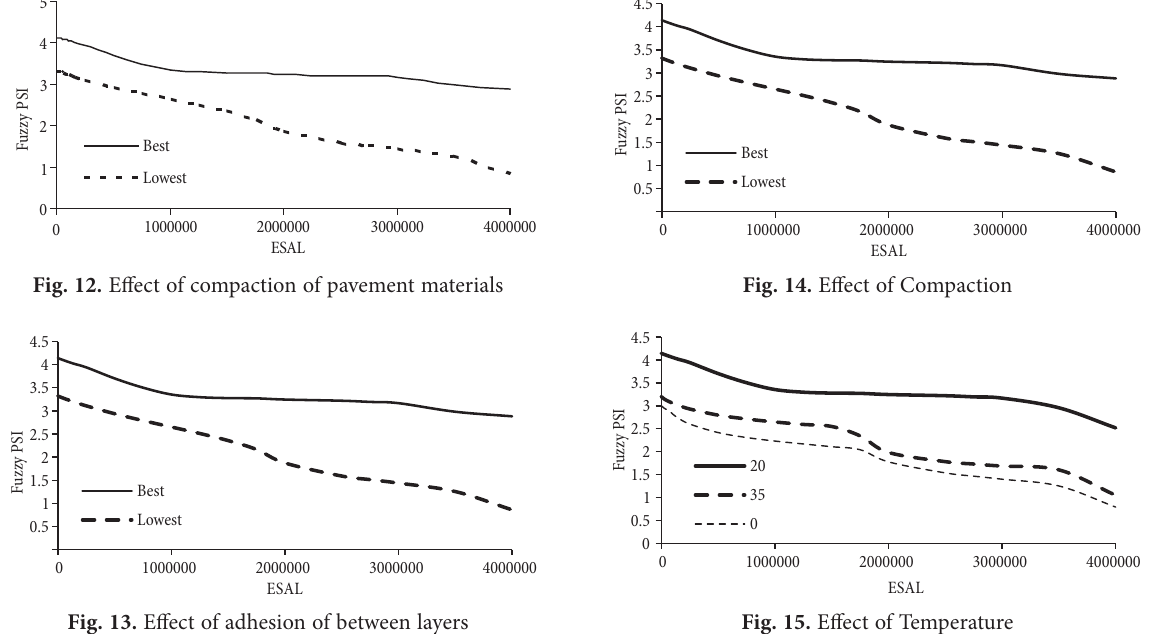
Fig. 15. Effect of Temperature